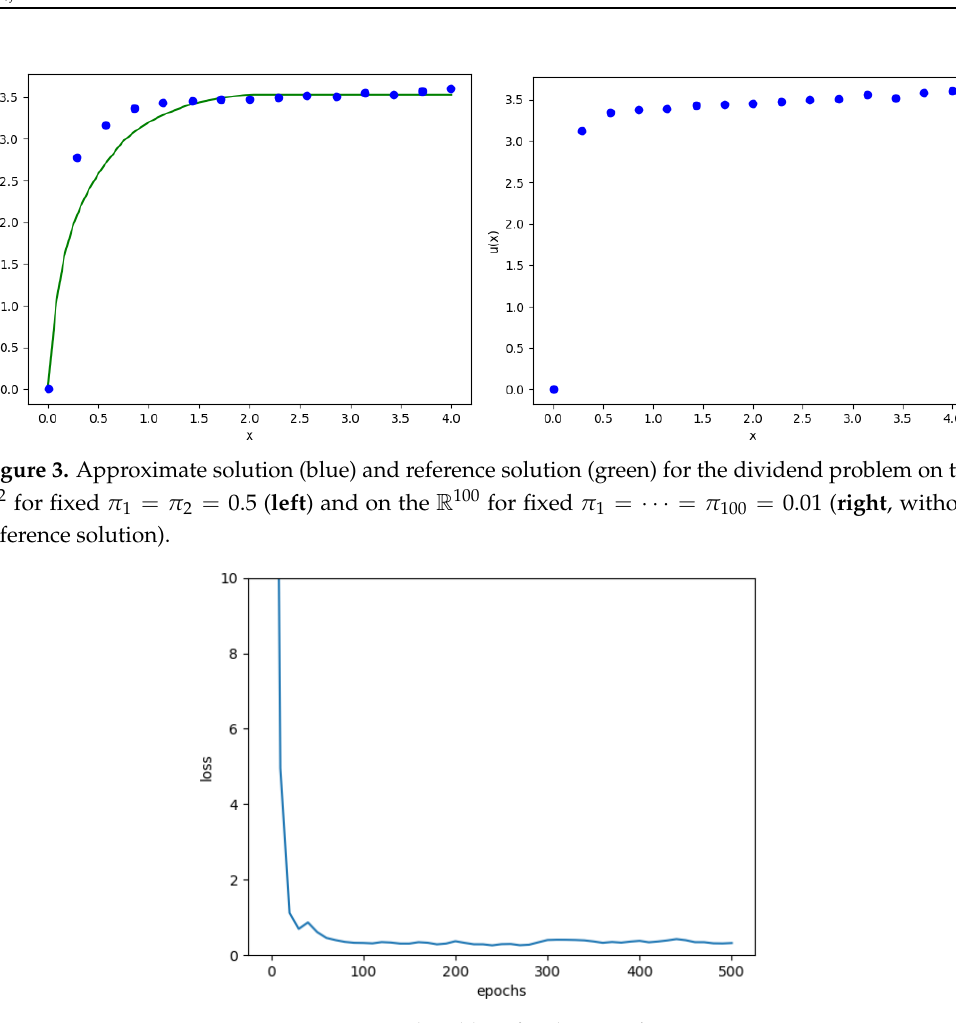
Figure 4. Interpolated loss for the case d =